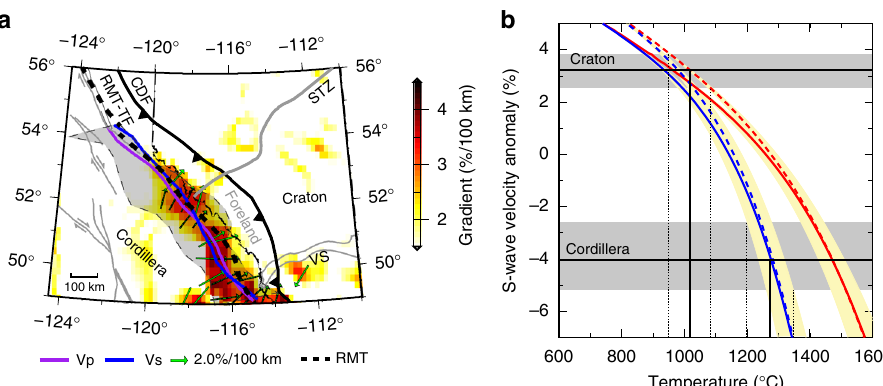
Fig. 3 Seismic velocity gradient and temperature contrast at the Cordillera – craton boundary. a Seismic velocity gradient at 150 km depth from an averaged Vp and Vs velocity model scaled using Vp/Vs ratios in the reference model 36 . The Cordillera – craton boundary in the upper mantle determined from P- wave and S-wave models are shown by the purple and blue lines, respectively. The shaded region highlights the spatial variation in the Cordillera – craton boundary location measured from this study and three recent tomographic models 29,30,35 (Supplementary Fig. 5). The green arrows indicate the direction of the maximum velocity gradient near the transition boundary. Major faults are marked by the gray lines. b S-wave velocity-temperature (Vs-T) relationship at 150 km depth. The horizontal black lines show the respective average S velocities for the Cordillera and craton regions, with the corresponding standard deviations shaded in gray. The solid and dashed curves represent pyrolite (fertile) and dunite (depleted) compositions, respectively, in a dry (50 ppm H/Si; red) and wet (5000 ppm H/Si; blue) mantle. The yellow shaded regions show the variations of Vs-T curves for various frequencies (0.03 – 0.3 Hz) and grain sizes (0.03 – 3 cm)